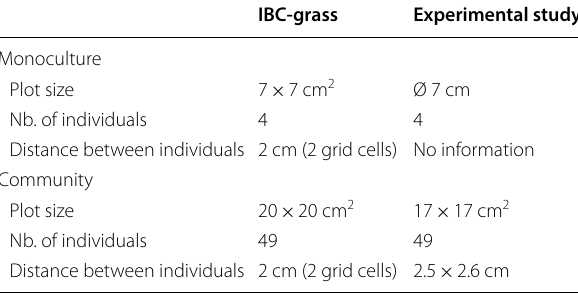
Table 1 Overview of the experimental setup compared to the model set up